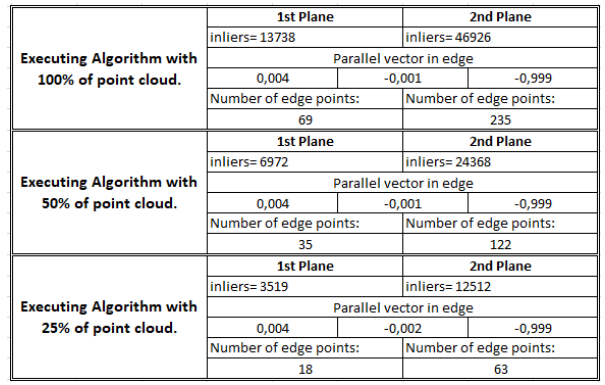
Table 1. Plane detection parameters for various levels of point cloud